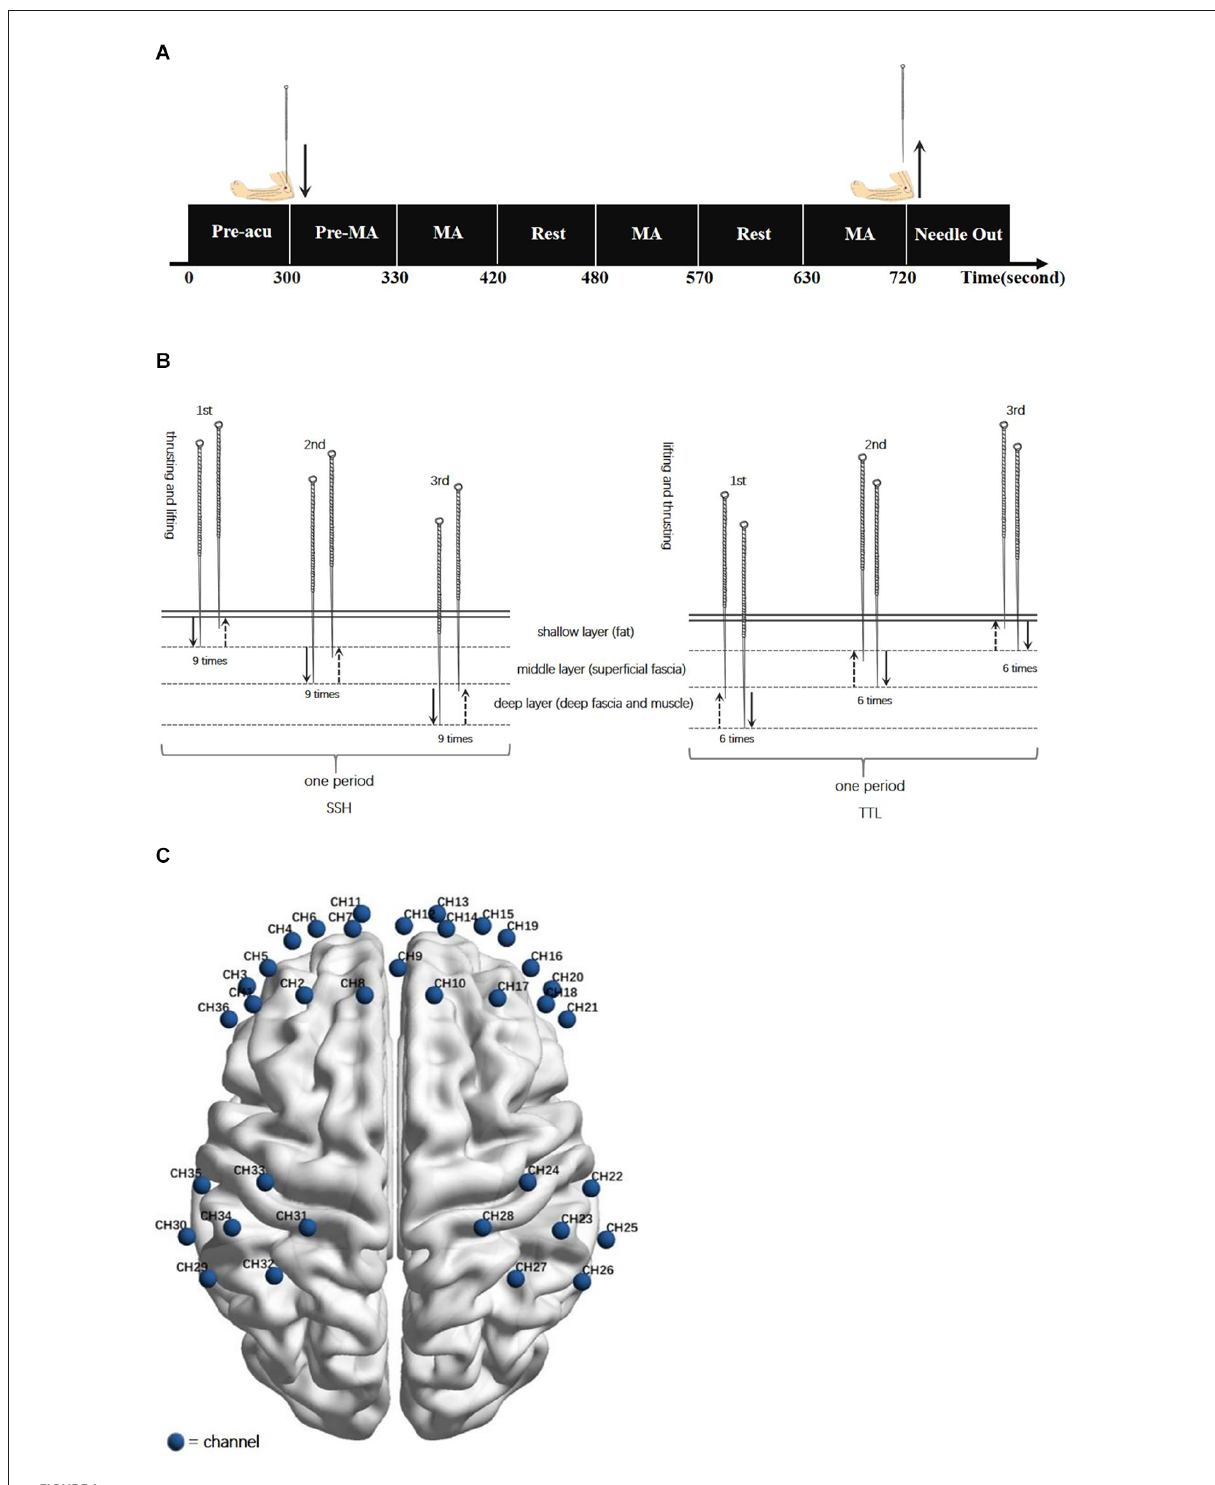
FIGURE1 (A) Acupuncture experiment paradigm. The experiment included a 300-s resting-state scanning (Pre-acu rest), a 30-s pre-manipulation (Pre- MA) stage for inserting a needle and twirling-rotating needle to obtain deqi sensation, and three 90-s blocks of acupuncture manipulation (MA) following by a 60-s interval resting state. (B) Acupuncture manipulations: SSH was from the shallow to the deep with nine times heavy swift thrusting and gentle slow lifting at each layer for one period, repeating the period for three times. TTL was from the deep to the shallow with six times heavy swift lifting and gentle slow thrusting at each layer for one period, repeating the period for three times. (C) fNIRS channel configuration. Locations of channels in the sensorimotor cortex and prefrontal cortex during the task fNIRS